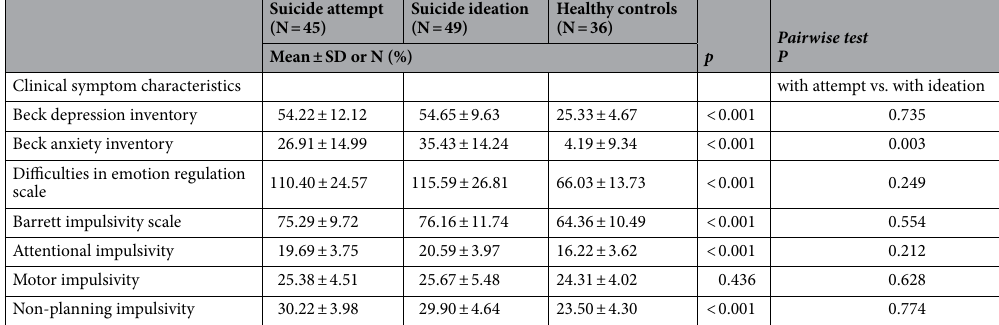
Table 2. Comparison of baseline clinical symptoms among MDD patients with suicide attempts and suicidal ideation, and healthy controls.